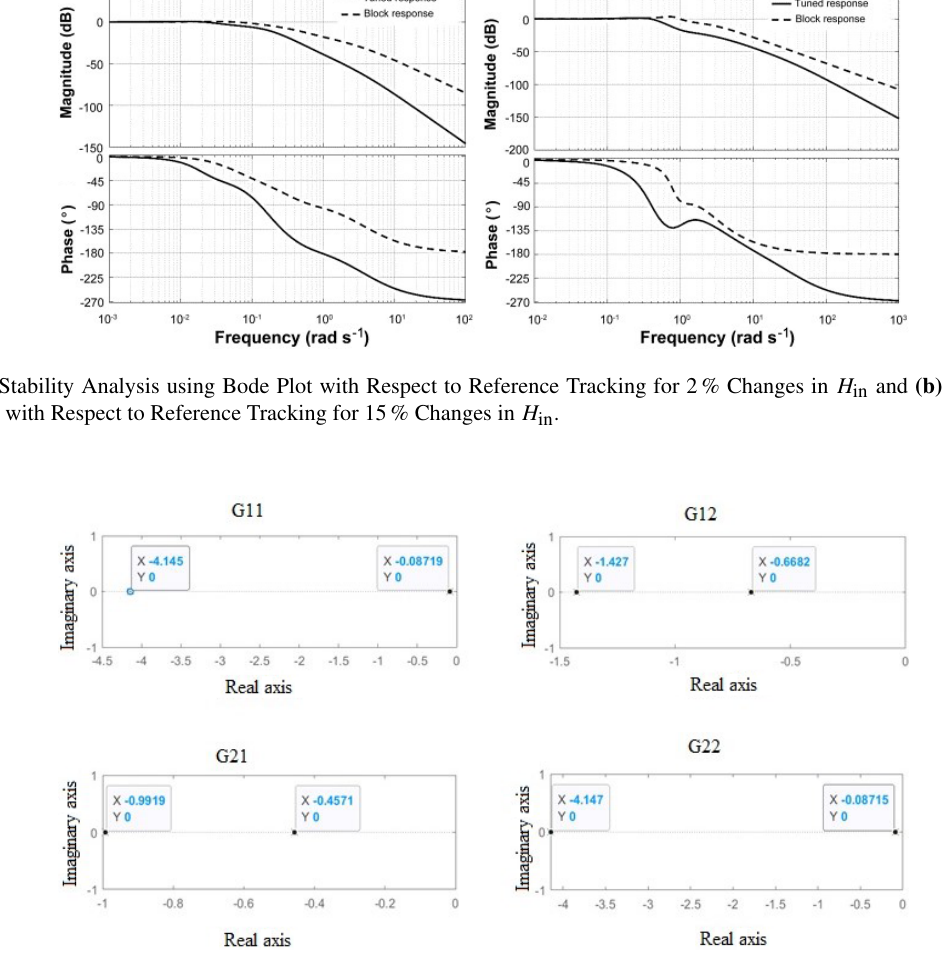
Figure 23. Illustration of Pole-Zero Map for Greenhouse